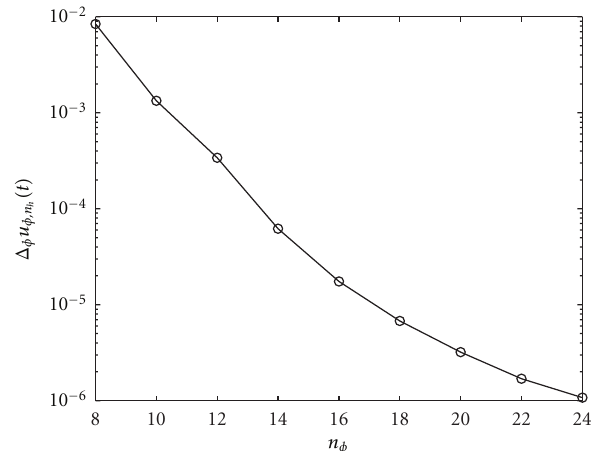
Figure 8: Error estimate (cid:4) 5.6 (cid:5) for two-dimensional case, for t (cid:2) 1 . 8, n h (cid:2) 101, α (cid:2) 1 , 5, k (cid:4) t (cid:5) (cid:2) cos (cid:4) t (cid:5) , and b (cid:4) t (cid:5) (cid:2) e − t . Closed boundary